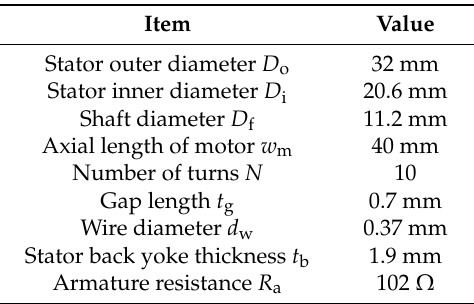
Figure 2. Structure of magnetic ring motor. A ring is provided on the outer circumference of the stator. Table 1. Motor specifications.